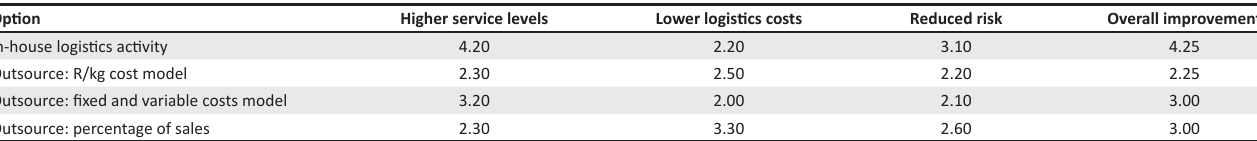
TABLE 8: Decision tree